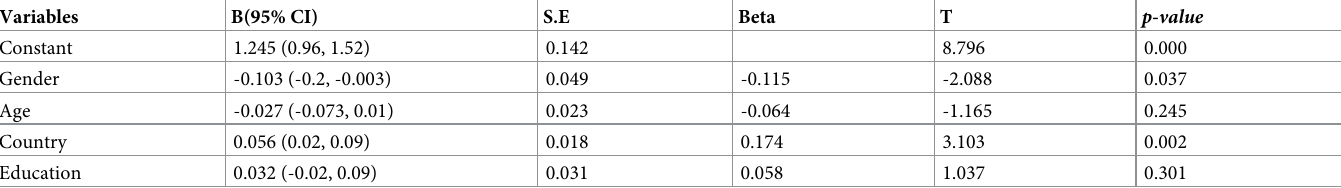
Table 10. Multivariable linear regression analysis on fear towards B.1.1.529.